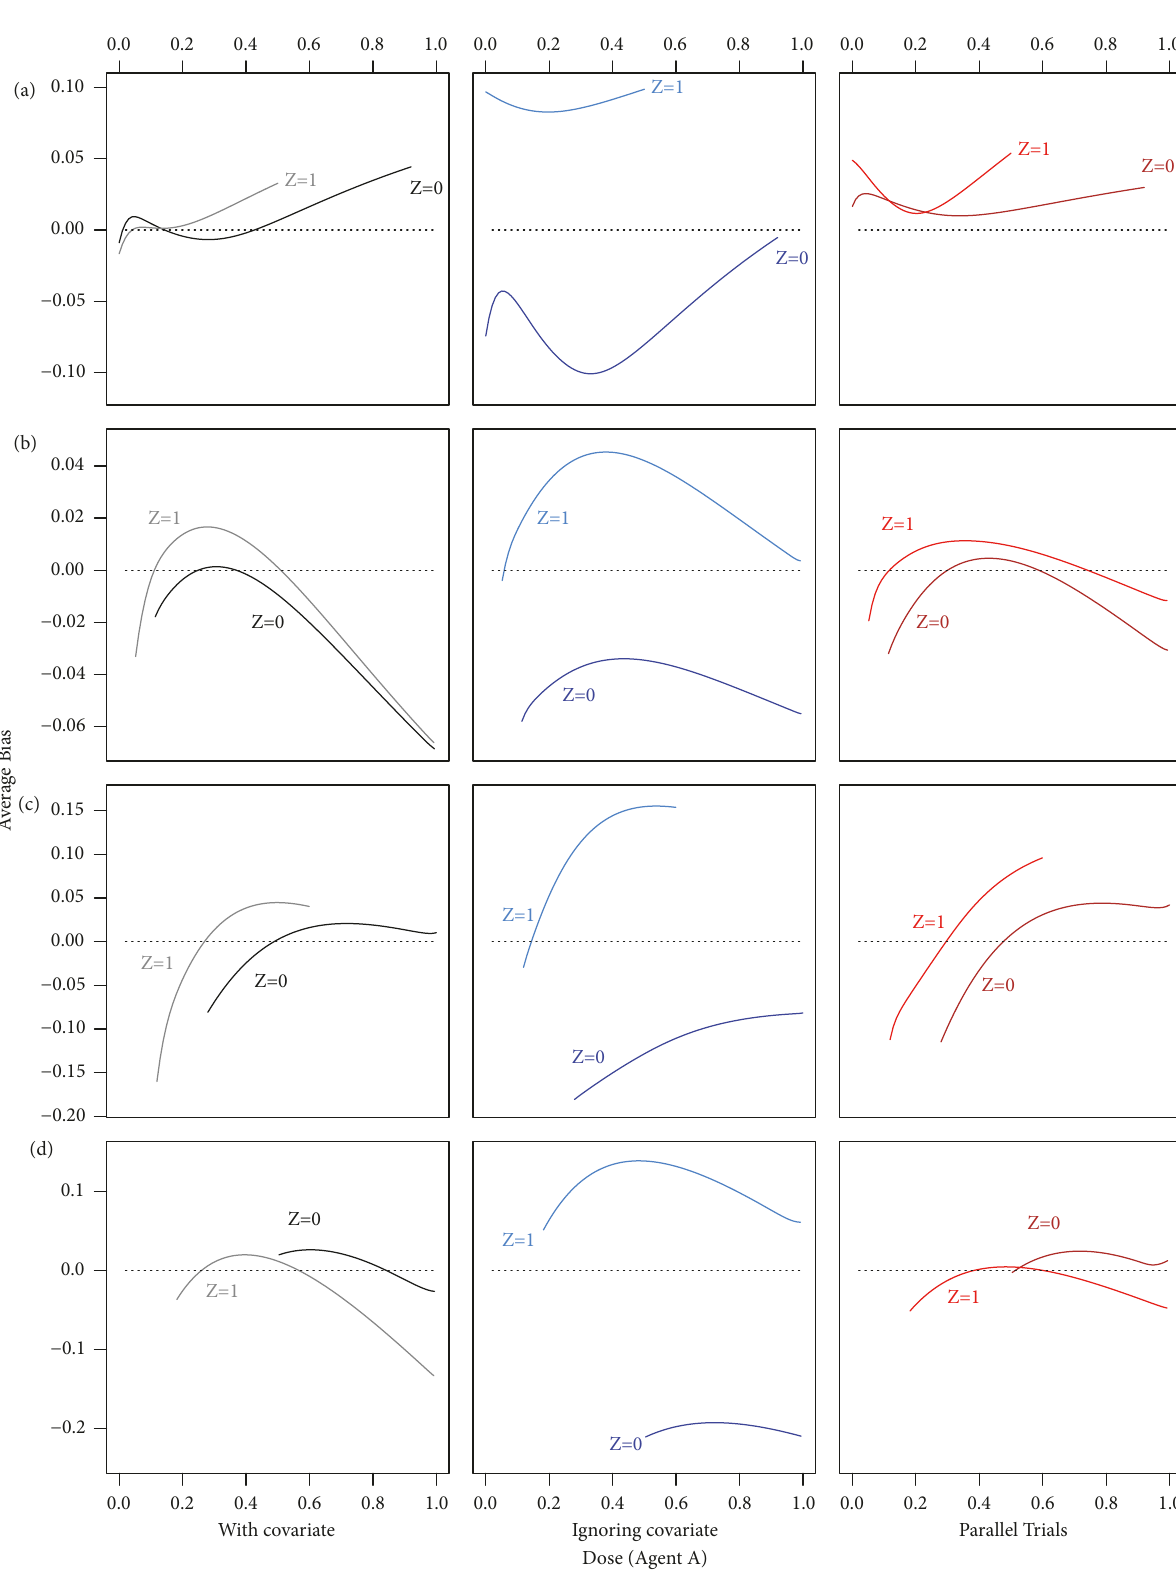
Figure 2: Pointwise averagerelative minimum distance from the true MTD curve to the estimated MTD curve with designs using a covariate (WC), ignoring the covariate (IC), and parallel trials (PT) under scenarios